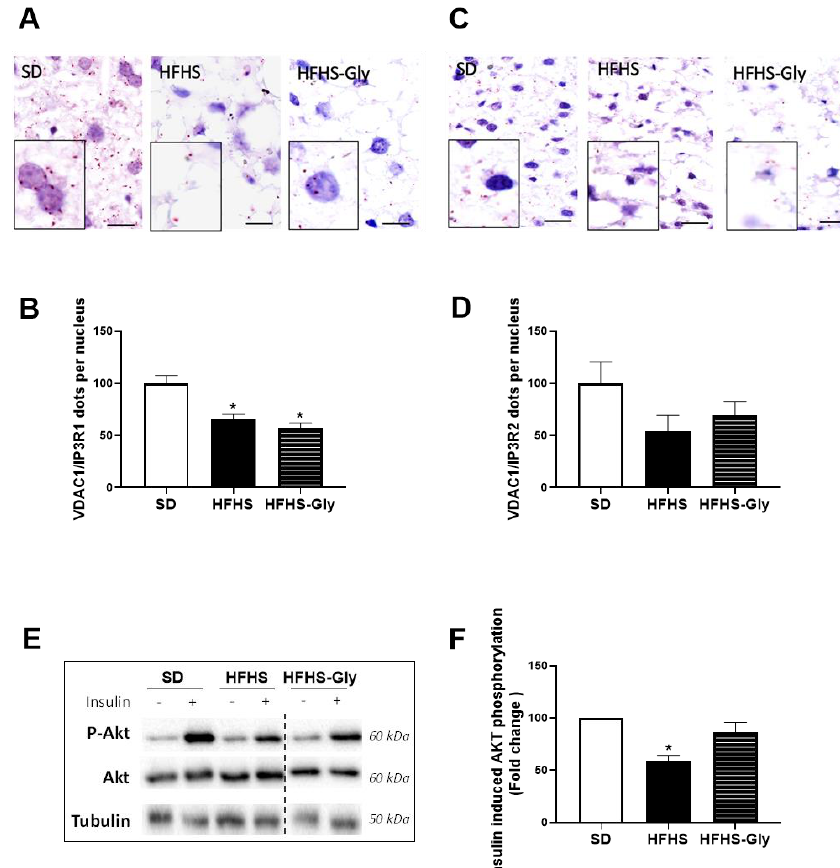
Figure 3. The impact of obesogenic diet and glycine on hepatic MAM integrity and insulin response. C57Bl6JOlaHsd mice were fed a standard diet (SD) or a high-fat high-sucrose diet (HFHS) for 16 weeks. Glycine supplementation (300 mg/kg/day) was given in drinking water during the last 6 weeks to half of the HFHS-fed mice (HFHS-Gly). ( A ) representative images (scale = 10 µ m) and ( B ) quantitative analysis of VDAC1/IP3R1 contacts per nucleus (n = 5 mice per group, n = 10 images/mouse). ( C ) representative images (scale = 10 µ m) and ( D ) quantitative analysis of VDAC1/IP3R2 contacts per nucleus (n = 5 mice per group, n = 10 images/mouse). ( E ) Representative images and ( F ) quantitative analysis of insulin (0.75 U/kg)-induced Akt phosphorylation (n = 5 unstimulated and 5 insulin-stimulated mice per group). Comparison of HFHS and HFHS-Gly vs. SD: * p < 0.05.